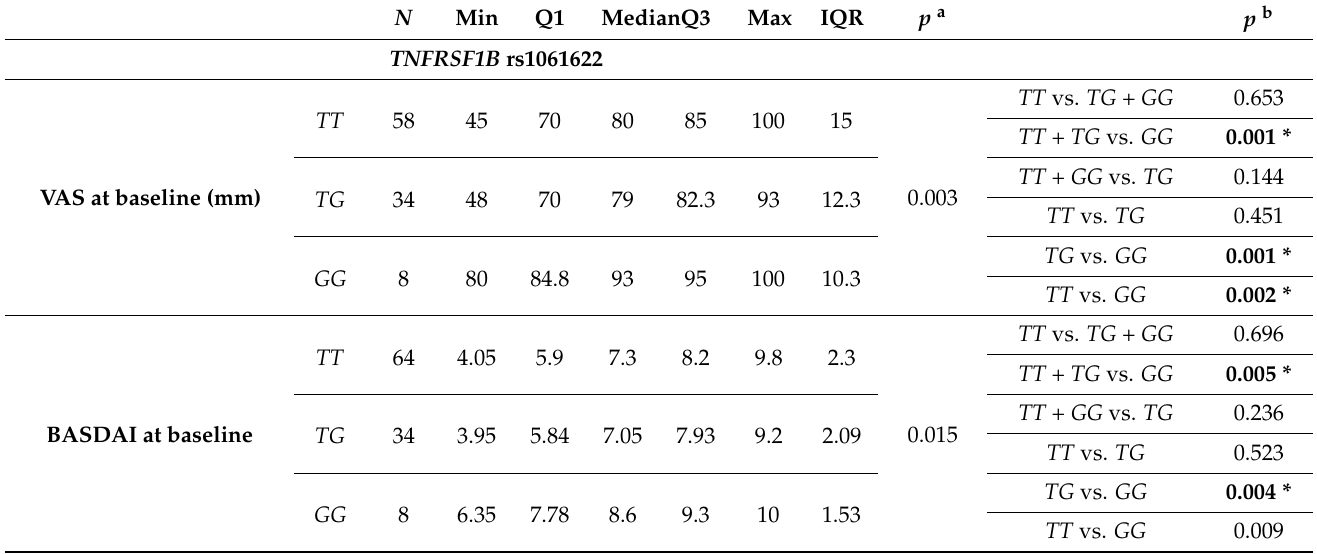
Table 4. Statistically significant associations between ERAP1, TNFRSF1B, TNFRSF1A, AND FCGR2A genotypes and clinical